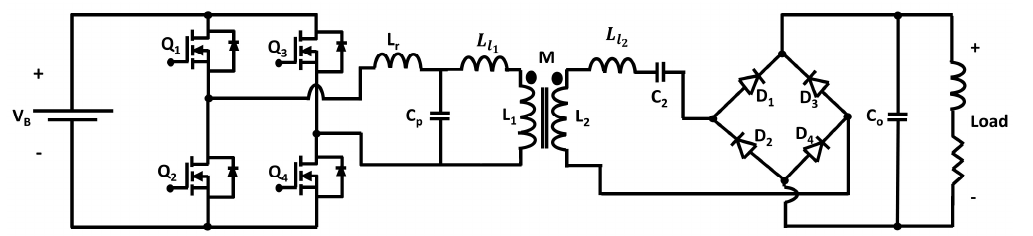
Figure 4. Isolated full-bridge LLC resonant converter.